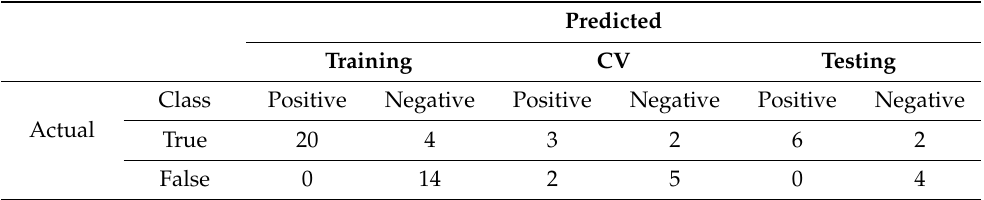
Table 9. Rebuild SA-based PNN model (SA-PNN) modeling result.